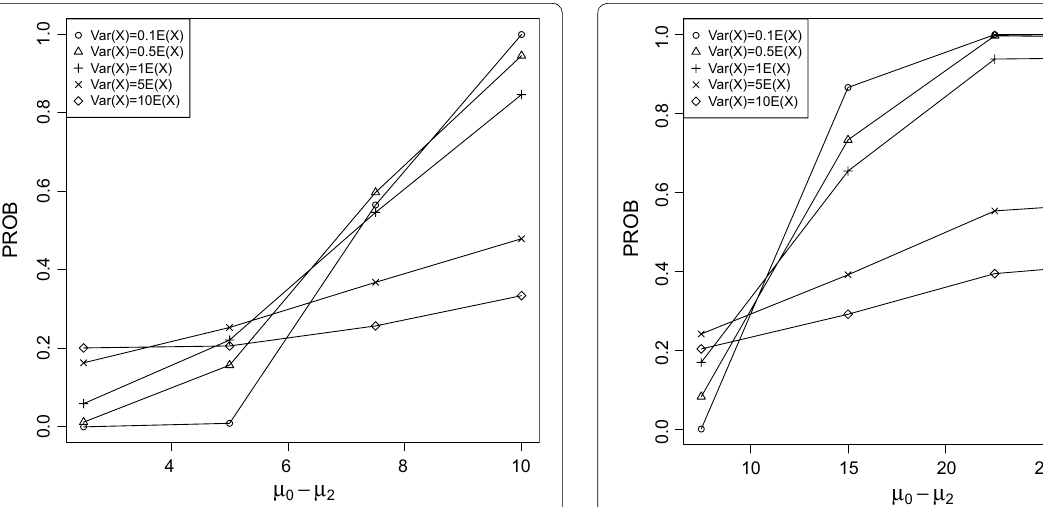
Fig. 2 PROB of the CPCAT; µ 0 = 25 , decreasing trend